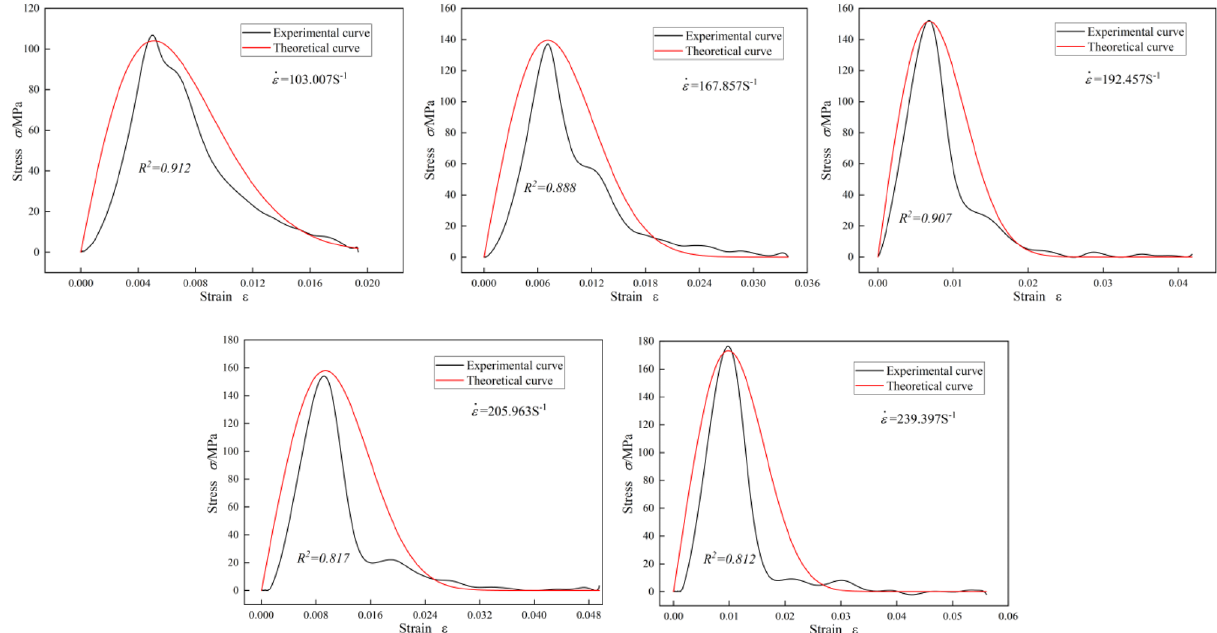
Figure 15. Theoretical curves and experimental curves of graphite ore rock under different strain